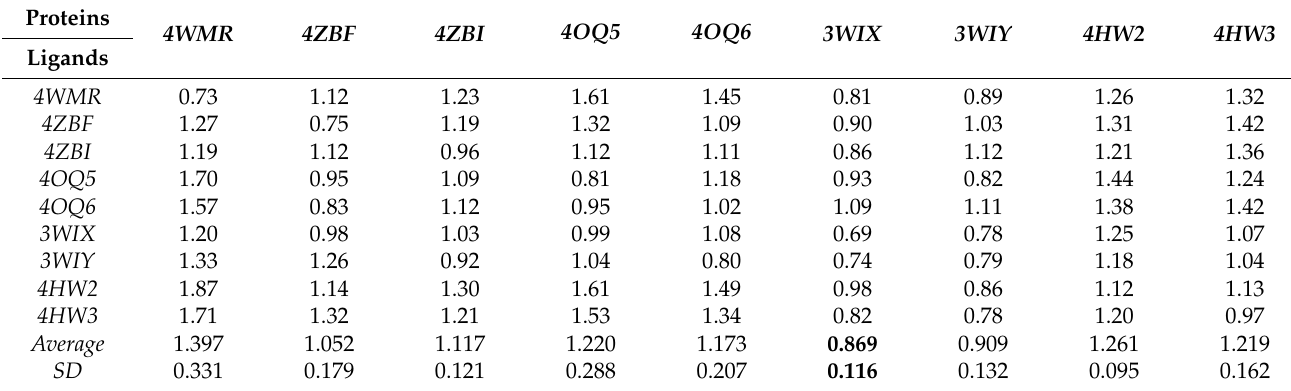
Table 3. MLC approach: docking of ligands and their respective RMSD values